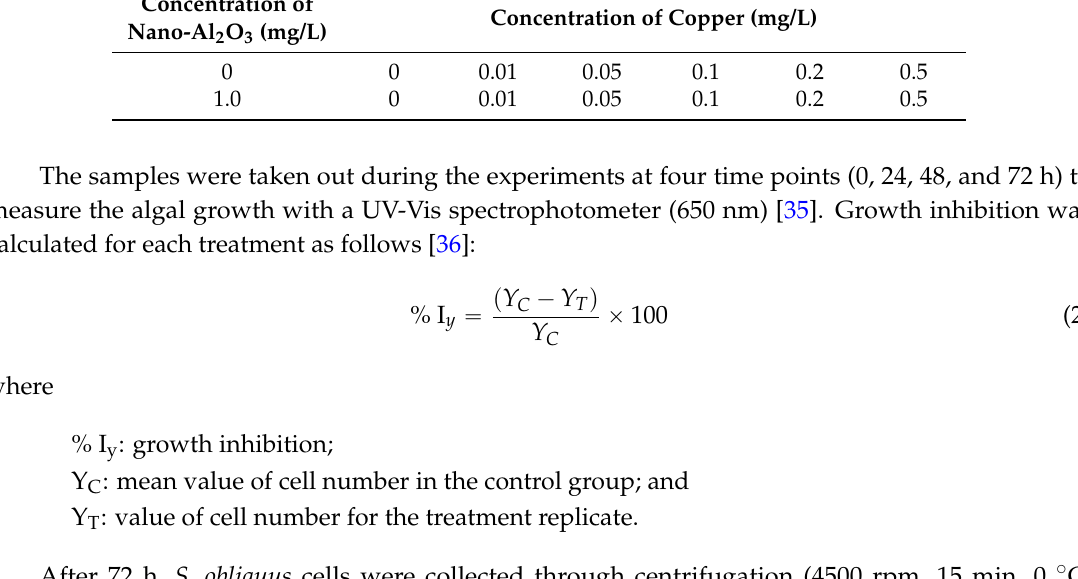
Table 2. Concentrations of copper and nano-Al 2 O 3 in the exposure solutions. Concentration